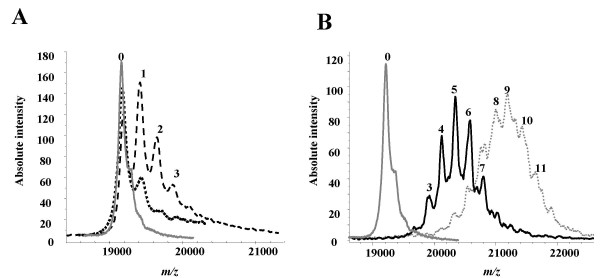
MALDI-TOF mass spectra of proteins labeled with NHS-biotin. Protein samples were mixed with various amount of NHS-biotin for 15 min at room temperature. Unlabeled protein mass spectrum is shown in grey solid line. Reagent/total lysine ratios were in Fig. 5A: 1:40 (black dotted line) and 1:20 (black dashed line), and in Fig. 5B: 1:2 (black solid line) and 2:1 (grey dotted line). The number of labeled lysines is indicated above each peak.